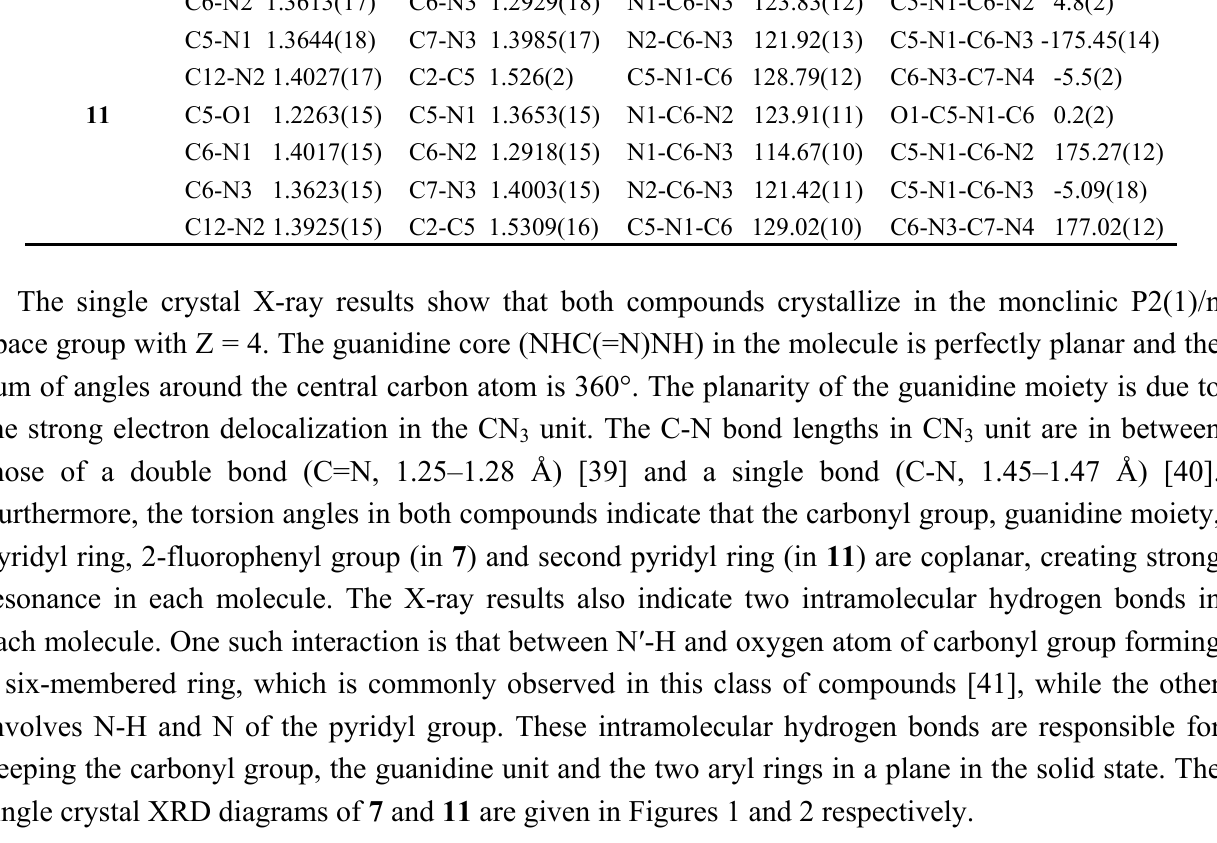
Figure 1. ORTEP diagram for N -pivaloyl- N ′ -(2.fluorophenyl)- N ′′ -pyridylguanidine ( 7 ). Thermal ellipsoids are shown at the 50% probability level. Hydrogen atoms are omitted for